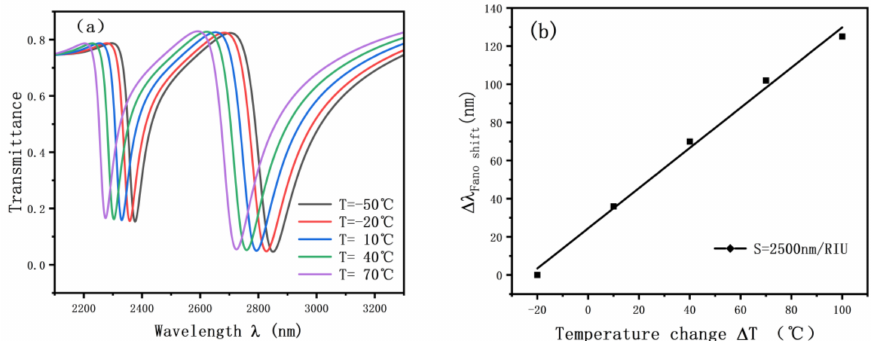
Figure 13. ( a ) Transmission spectrum of alcohol sensing; ( b ) fitting straight lines for alcohol